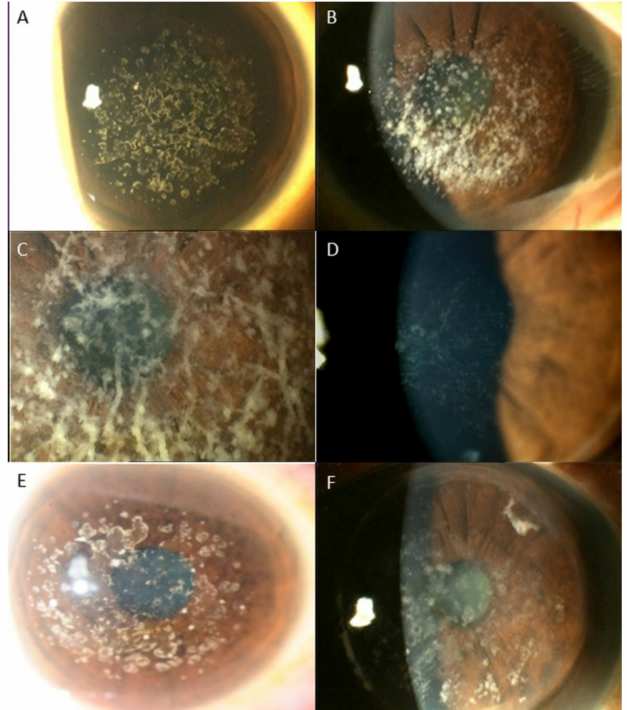
Figure 3. Different phenotypes of GCD1 associated with the same R555W mutation: ( A ): discoid lesions with central clearing; ( B ): White dots of varying densities, some coalescing to form white bands; ( C ): Star-shaped whitish lesions and dots with hazy intervening stroma; ( D ): Specks of translucent dots; ( E ): bread crumb like lesions sparing the peripheral cornea; ( F ): Grayish specks centrally and denser white dots that coalesce in the peripheral